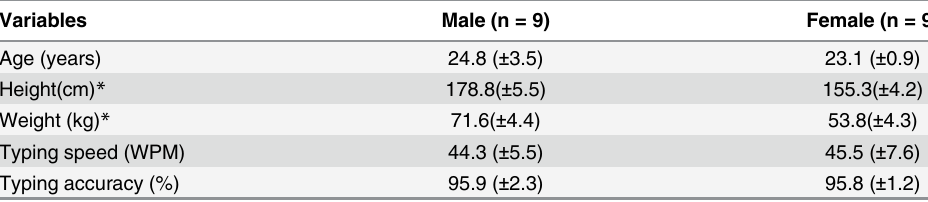
Table 1. Participant demographic characteristics and typing